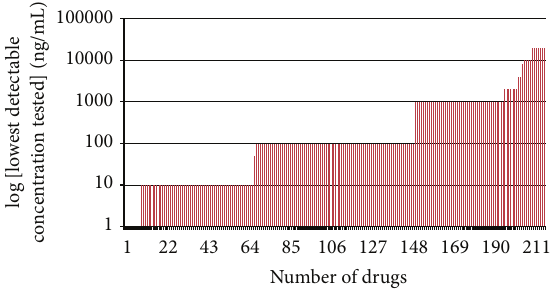
Figure 1: Lowest concentration of each of the 212 drugs detected by the new GC-MS platform. Dilutions of urine containing spikes of drug standards prepared by spiking 1, 10, 100, and 1000ng/mL into negative urine were used to determine the analytical sen- sitivity of the platform. If the drug could not be detected at the lowest concentration tested, the next higher concentration of the drug was analyzed. Analytical sensitivity of the drug was recorded as the lowest formulated concentration at which the drug was detected (see Supplementary Material available online at http://dx.doi.org/10.1155/2013/329407 for the list of all drugs along with the lowest concentrations at which each drug was